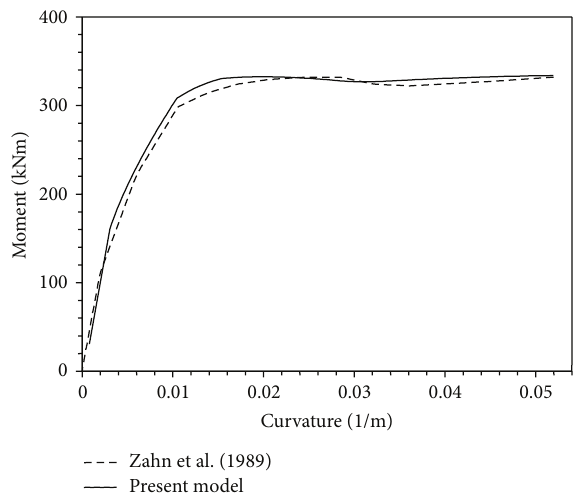
Figure 7: Calibration of constitutive law of confined concrete.